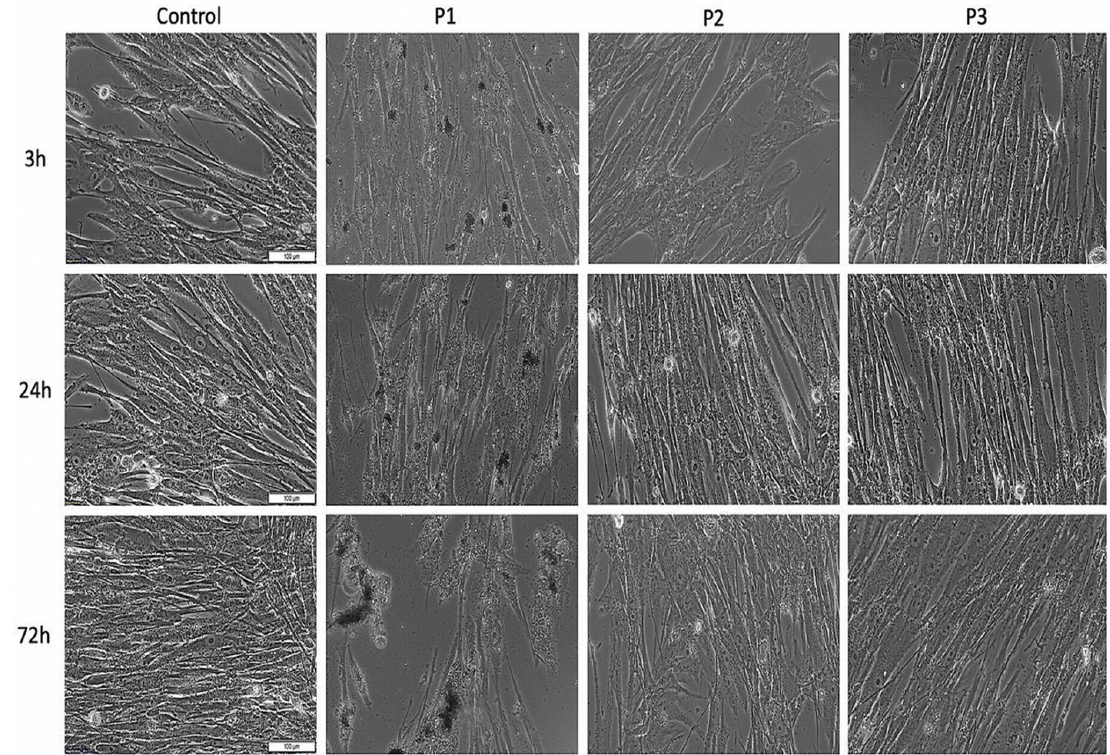
Figure 3. Morphological aspects of primary human gingival fibroblasts (HGFs) cells after treatment with extraction medium of test orthodontic implants (P1, P2, P3). Pictures were captured at a magnification of 20 × . Scale bars represent 100 µ m.